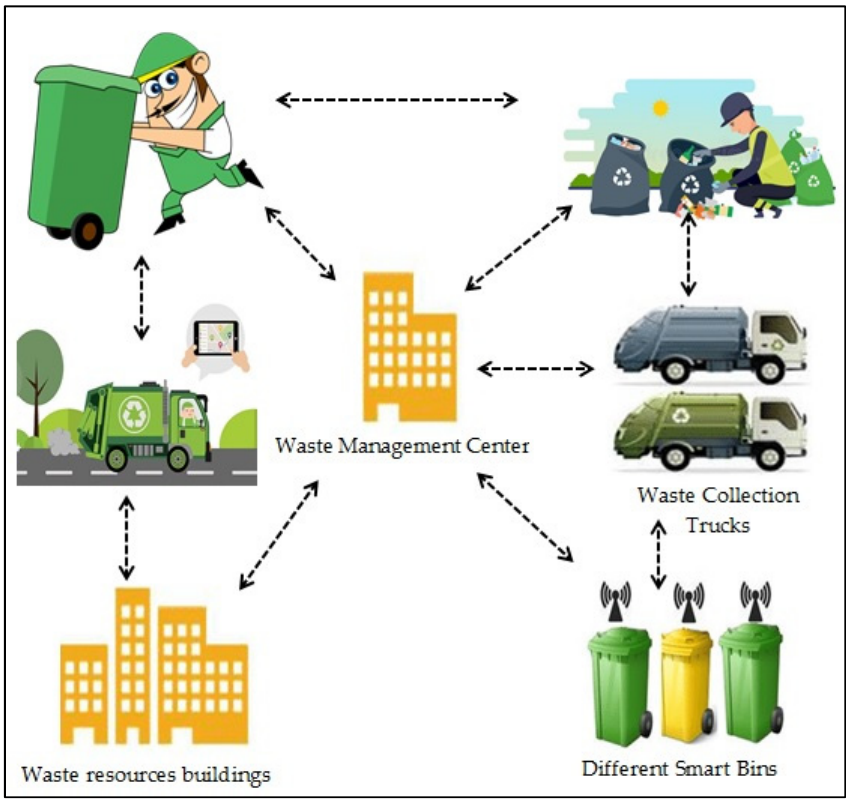
Figure 2. WMS architecture.